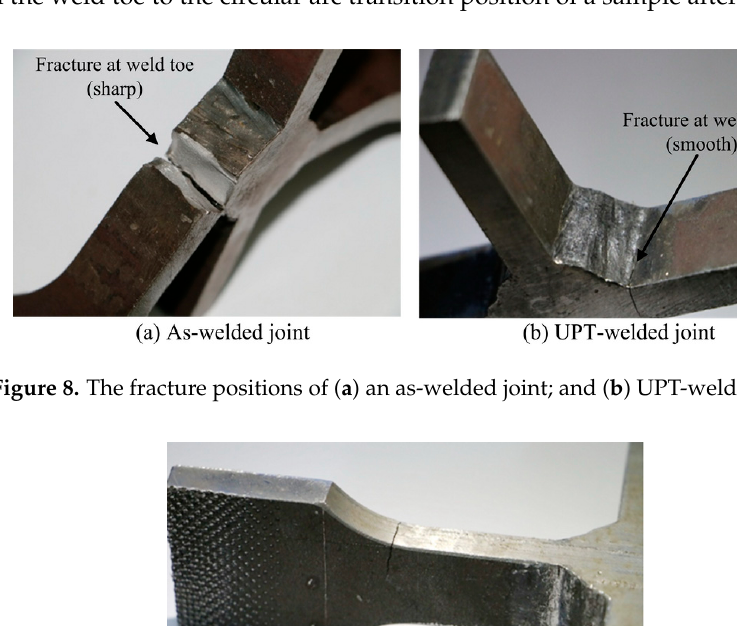
Figure 8. The fracture positions of ( a ) an as-welded joint; and ( b ) UPT-welded joint.